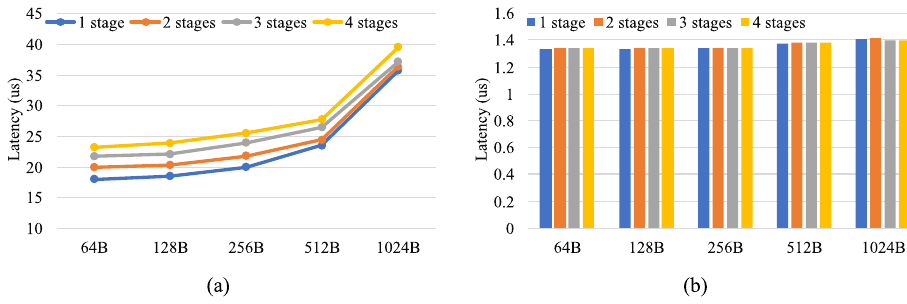
Figure 10. The latency of the ( a ) CPU and ( b )